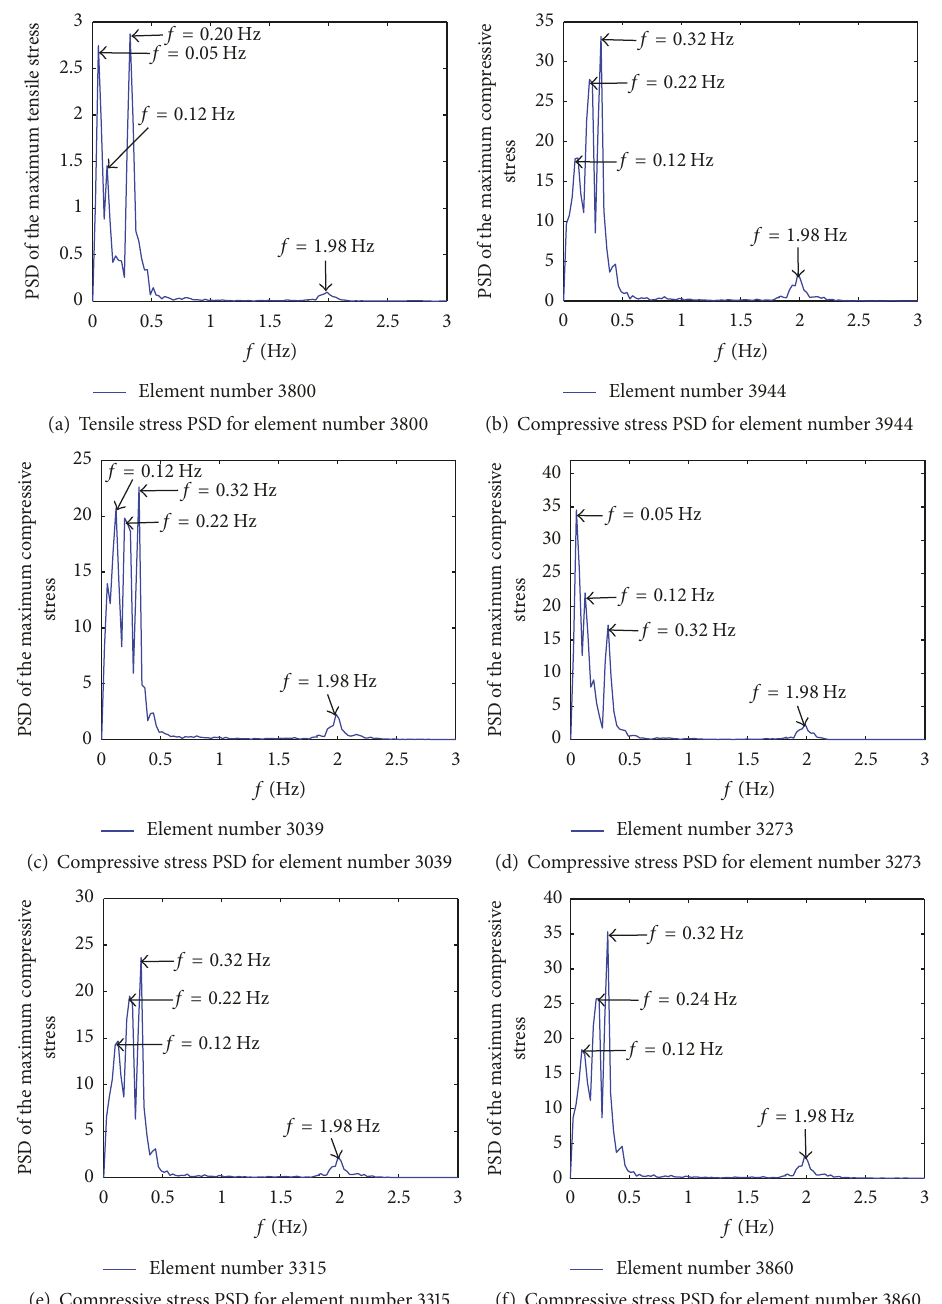
Figure 19: The stress PSD of the main members of the transmission tower in the tower-line system under a wind speed of 𝑈 10 = 6.03 m/s.